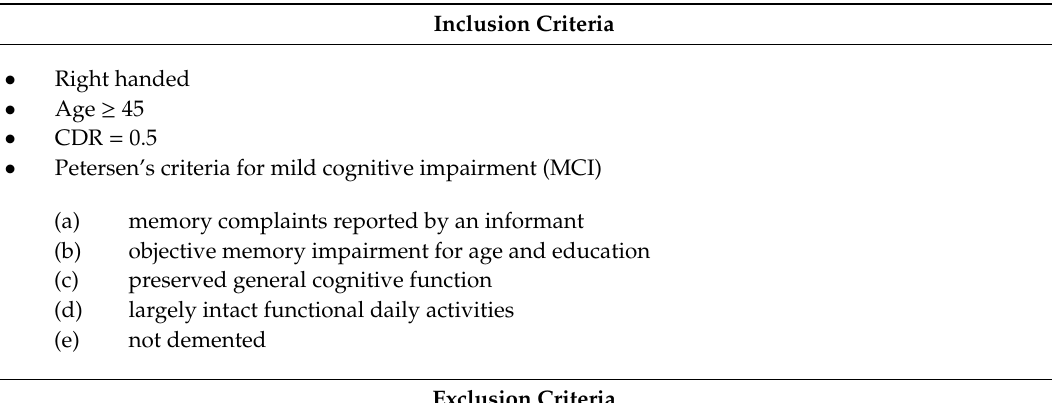
Table 1. Inclusion and exclusion